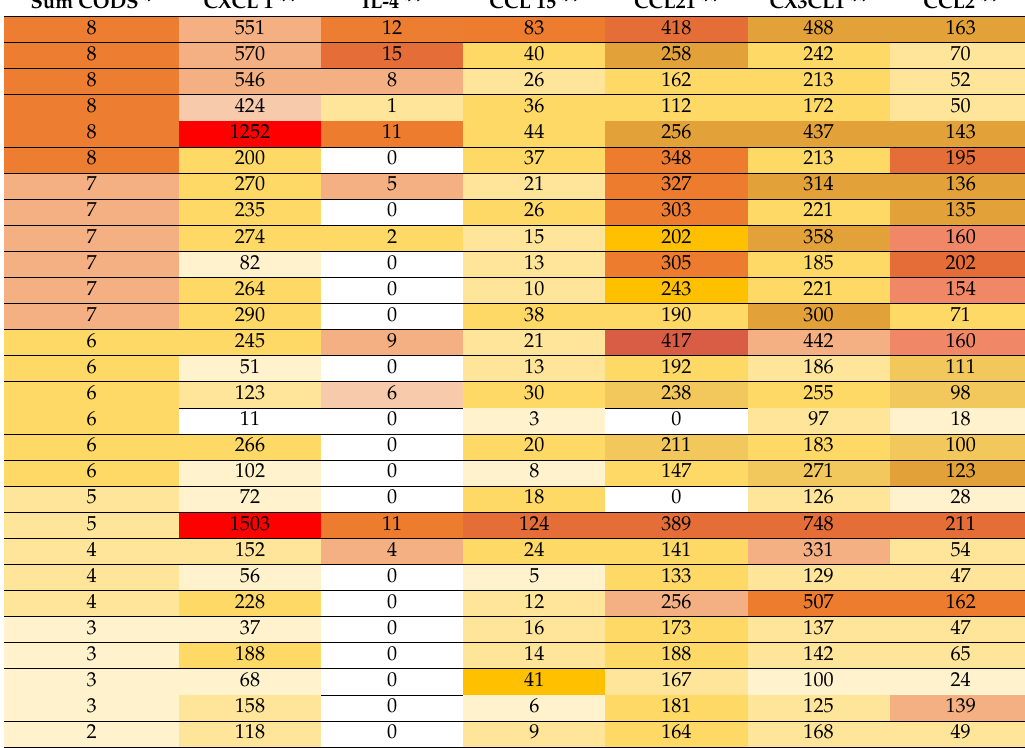
Table 2. Summed CODS scores vs. concentration of upregulated salivary cytokines identified in head and neck cancer